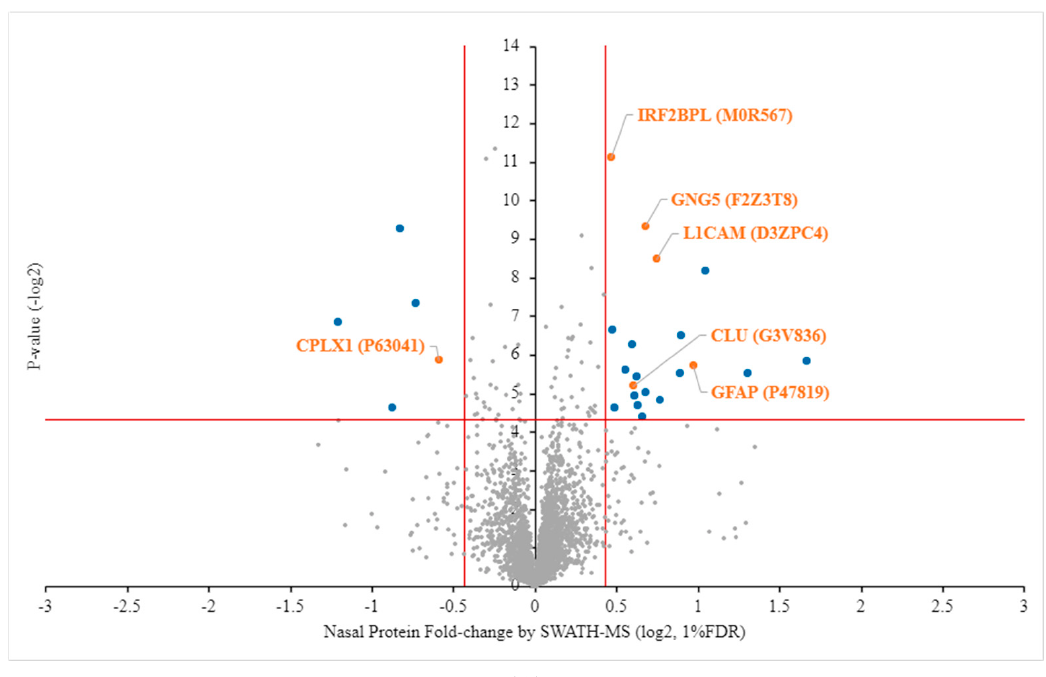
Figure 3. Volcano plot of proteins quantified using SWATH-MS. A plot of protein fold-change (log2, x -axis) and p -values (-log2, y -axis). Significantly differentiated unique proteins in quadrant positions (blue) and shared proteins (orange) were determined by p -values < 0.05, fold-change log2 > 0.43 (up-regulation) or ≤− 0.43 (down-regulation) and a 1% false discovery rate (FDR). ( A ) Left temporal (LT) compared to right temporal (RT). ( B ) Left nasal (LN) compared to right nasal (RN). Names of shared proteins are shown. Table 2. Protein regulation in the temporal quadrant 2 weeks after pONT compared to contralateral control ( p < 0.05 and fold-change log2 > 0.43 (upregulation) or ≤− 0.43 (downregulation)). R = right; L = left; FC = fold change.